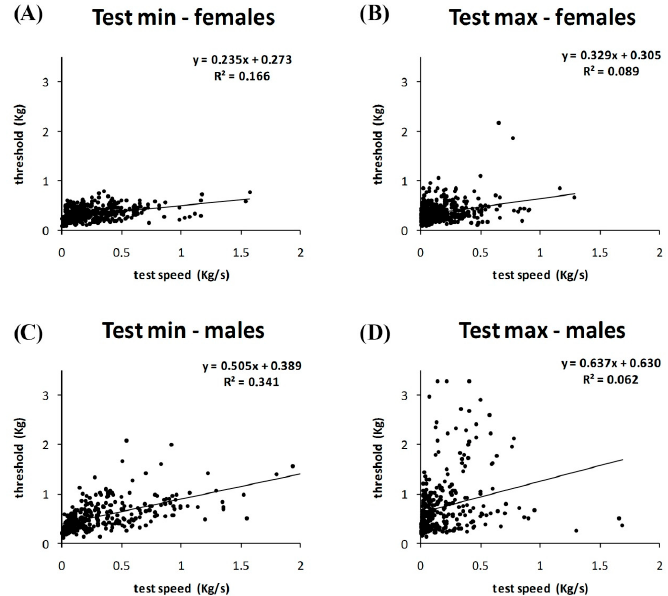
Figure 5. Difference in ( A , B ) female and ( C , D ) male participants.